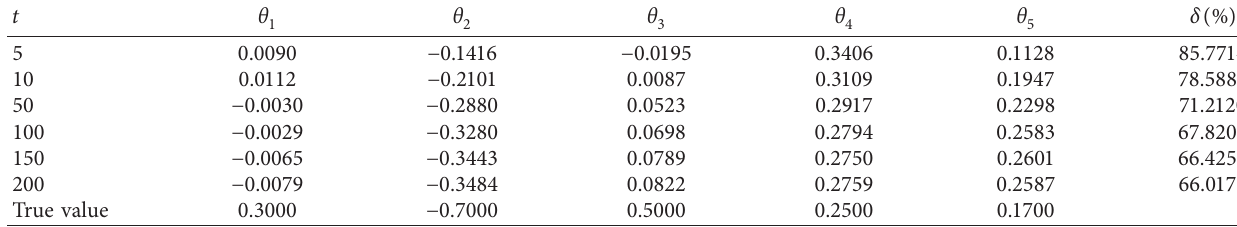
Table 1: The parameter estimates and the estimation errors (SG).